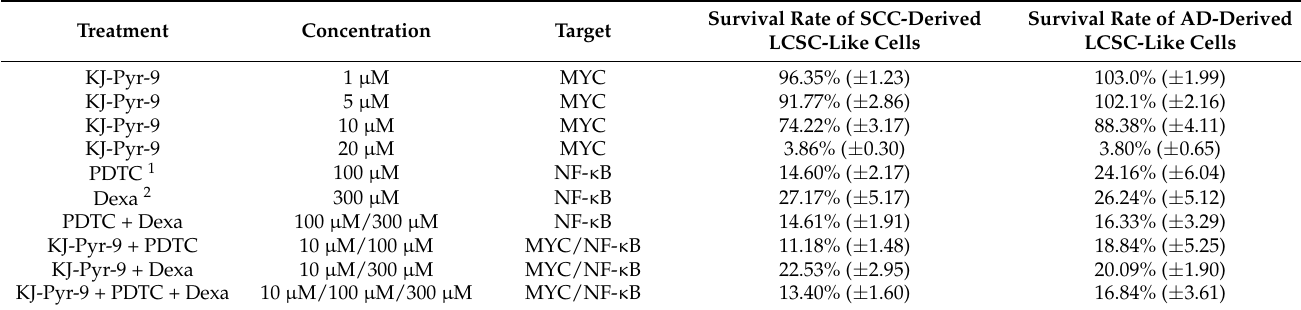
Table 2. Survival rates of squamous cell carcinoma (SCC)- and adenocarcinoma (AD)-derived lung cancer stem cell (LCSC)-like cells after the application of different NF- κ B inhibitors and the MYC inhibitor KJ-Pyr-9. Treatment